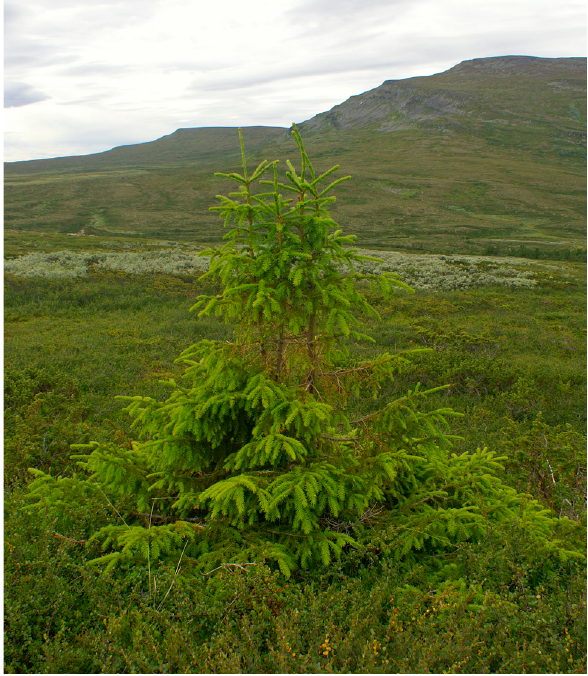
Figure 20: Spruce tree growing in the zone where the tree- line advanced relative to early 20th century. During the past 2-3 decades, annual shoots have been exceptionally long. Mt. Anåkroken, 990 m a.s.l. 1 August